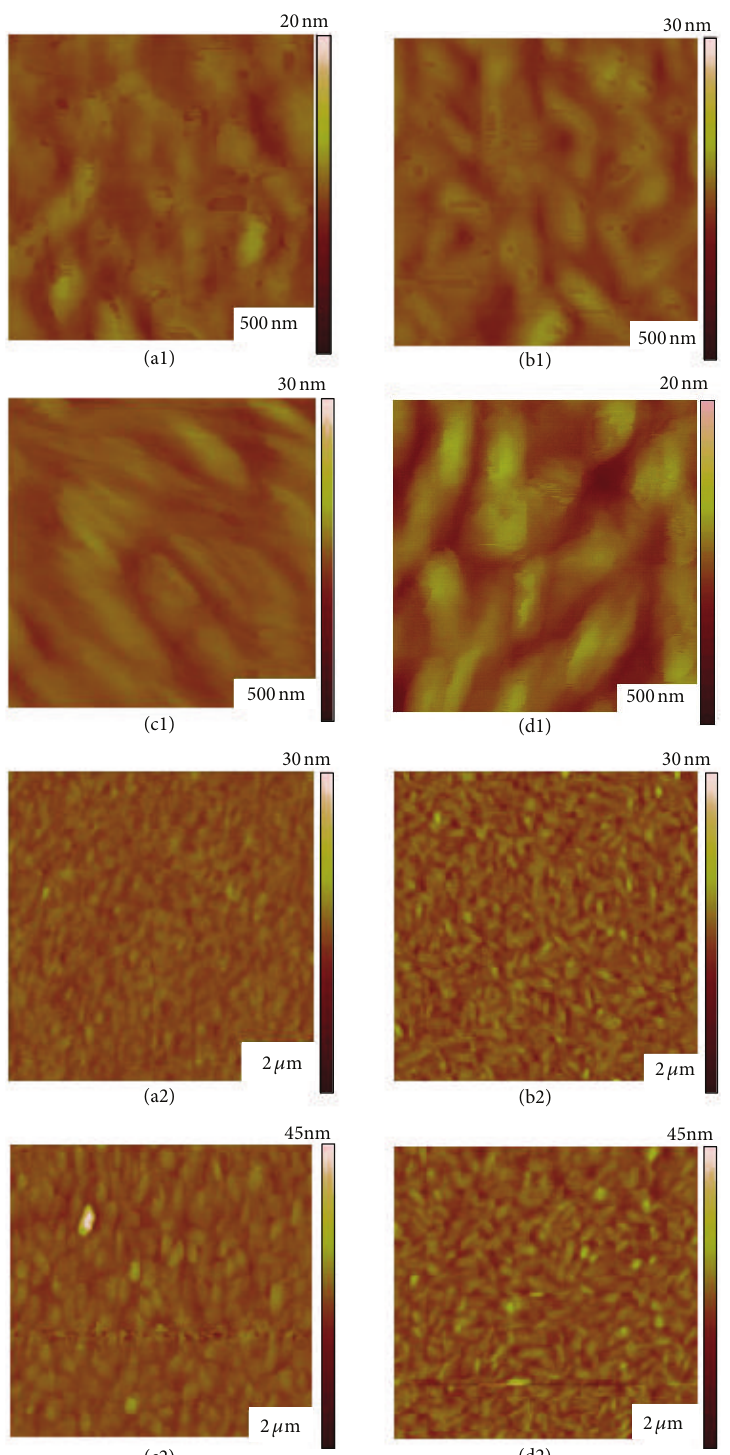
Figure 1: AFM images for PTCDI-C8 films with (a) 20, (b) 27, (c) 33, and (d) 45nm thickness deposited on Si substrate at room temperature for scan sizes of 500 × 500 nm 2 and 2 × 2 𝜇 m 2